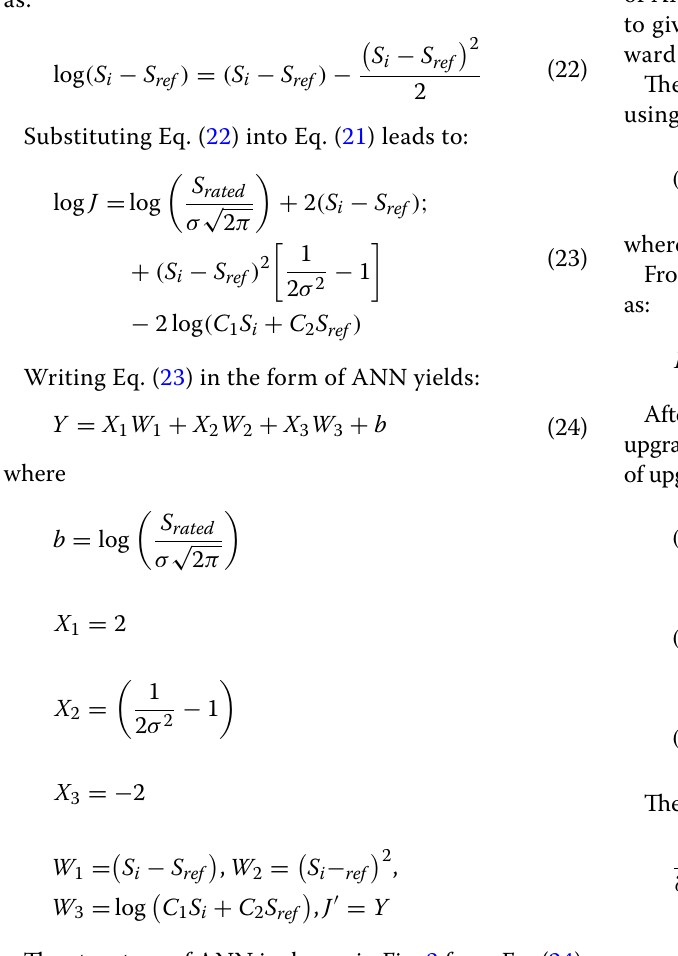
The structure of ANN is shown in Fig. 3 from Eq. (24). Figure 3 is the open loop structure for determining the optimal location of DGs. In this case; a proper solution is not obtained while the parameters used in this struc- ture are shown in Table 8.